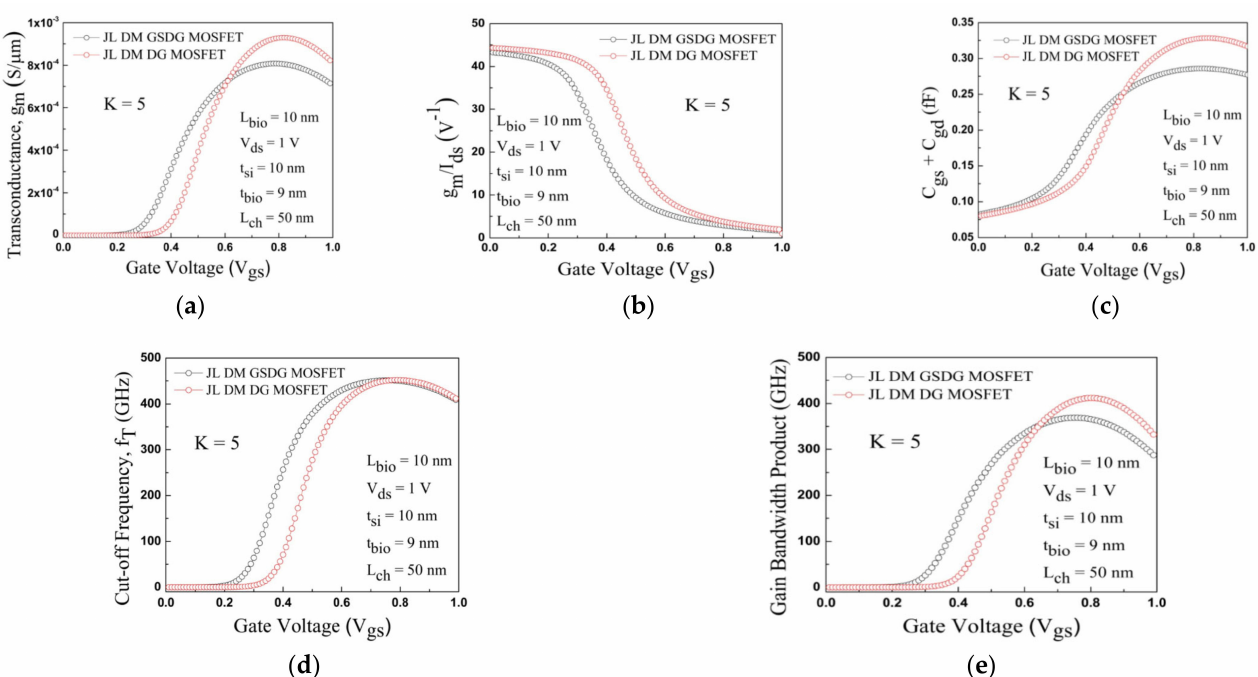
Figure 15. Plot of ( a ) g m , ( b ) g m /I ds , ( c ) C gs + C ds , ( d ) f T , and ( e ) GBP with gate voltage for JL-DM- DG-MOSFET and JL-DM-GSDG-MOSFET biosensor at K =